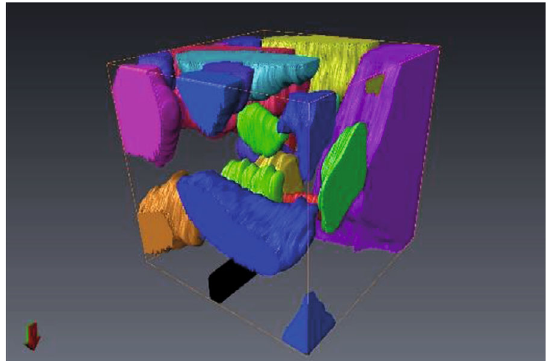
Figure 8: Spatial distribution of mineral particles in the original specimen. This fi gure represents a CT 3D reconstruction image of the distribution of the main gravel particles above the prefabricated cracks (black areas) of the sample. The size of the cube in the fi gure is 37161 : 66 × 37161 : 66 × 37161 : 66 μ m 3 . In the sample, there are about 29 gravels present in the cube area, and the average volume is 8 : 84 × 1010 μ m 3